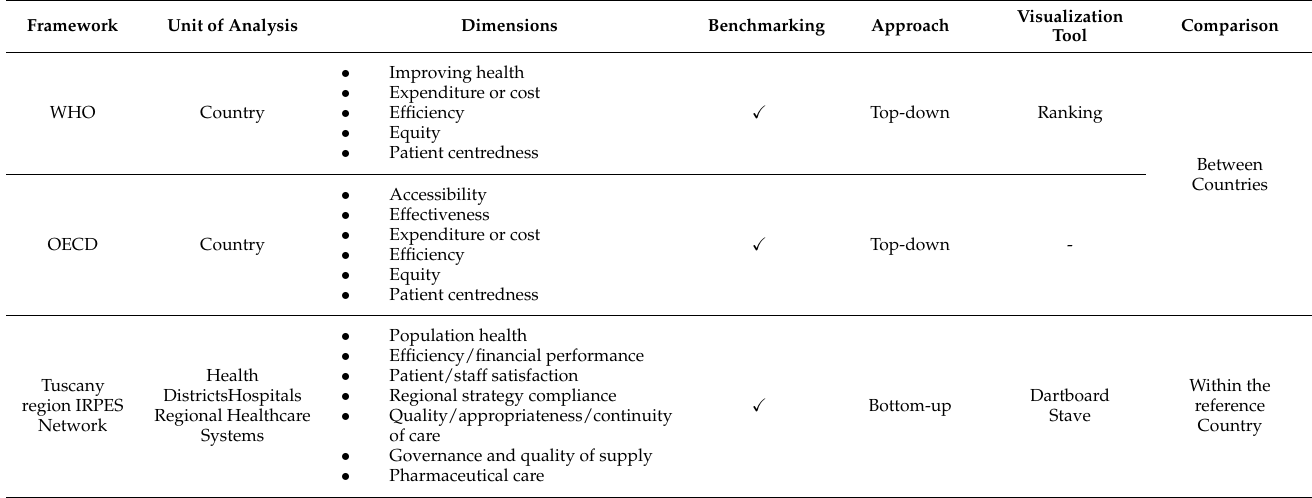
Table 1. Theoretical framework analysed, i.e., WHO, OECD, and Italian PES. Framework